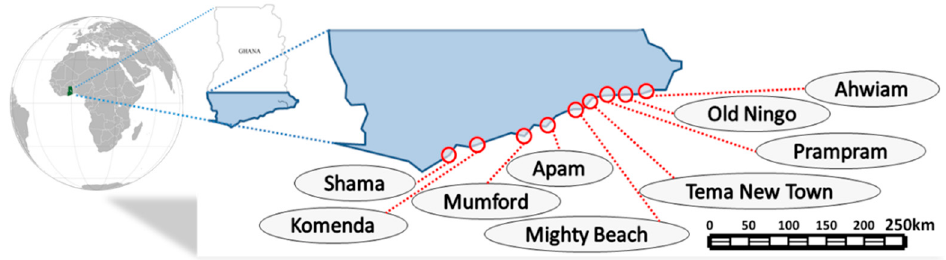
Figure 1. The coastline of Ghana and the relevant locations from which H. musciformis was collected (January 2015) by an experienced taxonomist.